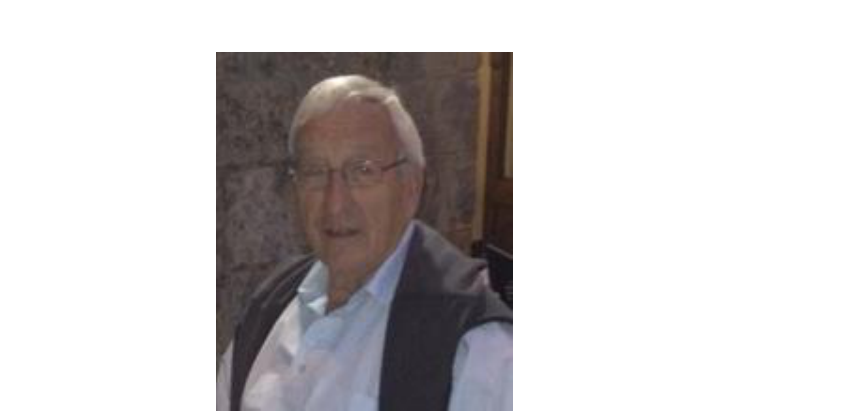
Figure 1. Jan at “Il Palio” (Sienna, Italy, September